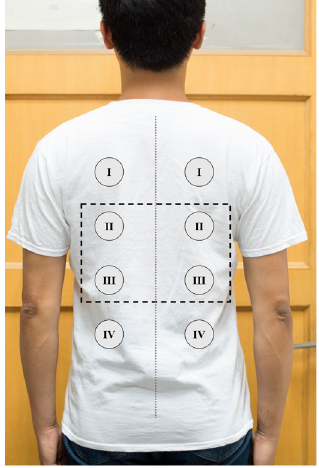
Figure 10. Different electrode positions. Table 1. QRS peak amplitude results.